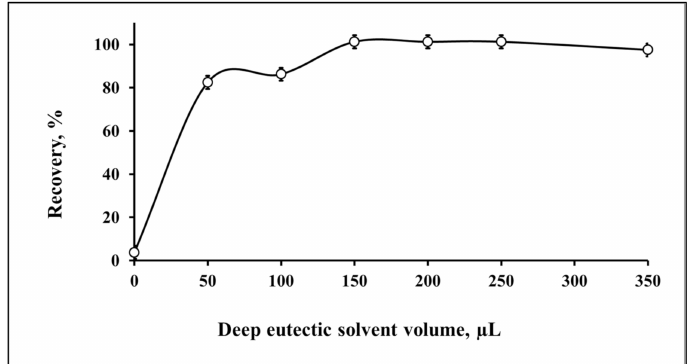
Figure 2. Optimization of the amount of the deep eutectic solvent for the recovery of Pb(II) by microextraction ( n = 3).